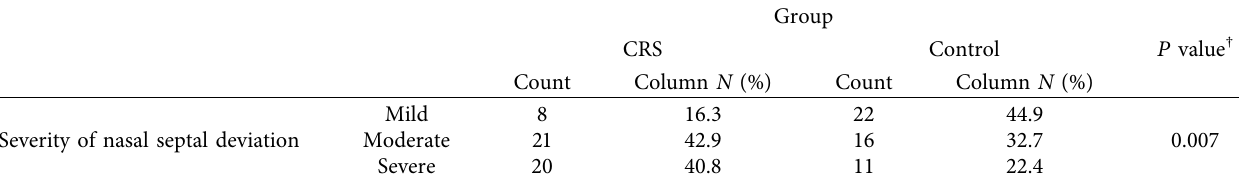
Table 1: Severity of septal deviation in the two groups.